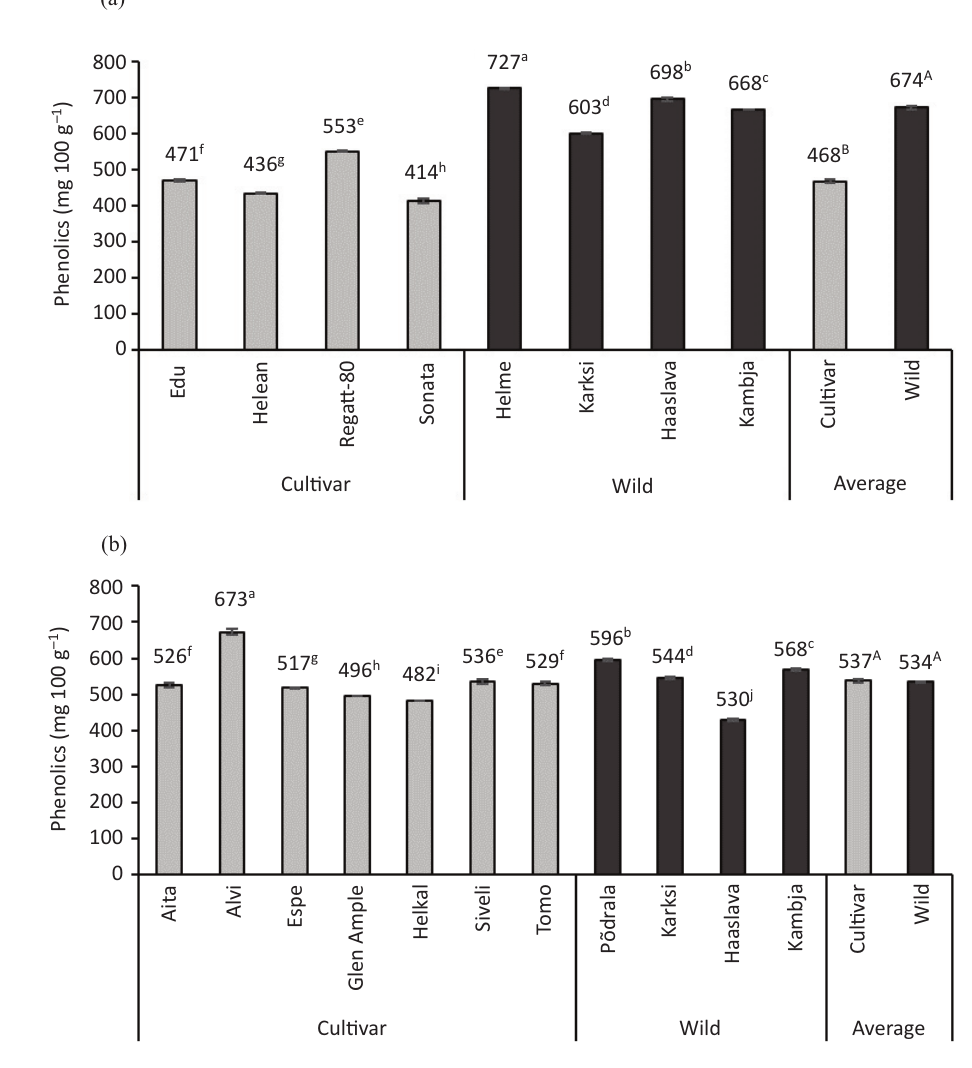
Fig. 2. Total phenolic content (mean ± standard deviation) of strawberry ( Fragaria × ananassa ) ( a ) and raspberry ( Rubus idaeus ) ( b ) cultivars, wild strawberry ( F. vesca ), and wild raspberry ( R. idaeus ). Different letters (a - j) indicate significant ( p <0.05) difference among all cultivars and wild relatives. Different letters (A, B) indicate significant ( p <0.05) difference between average values of cultivars and wild